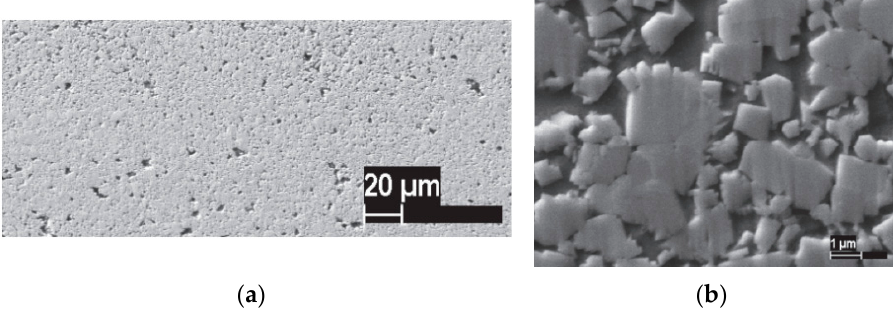
Figure 16. SEM micrographs of WC-20Co material processed by EDC for input energies of: ( a ) 87 kA/cm 2 ; ( b ) 95 kA/cm 2 . Reprinted from ref. [90]